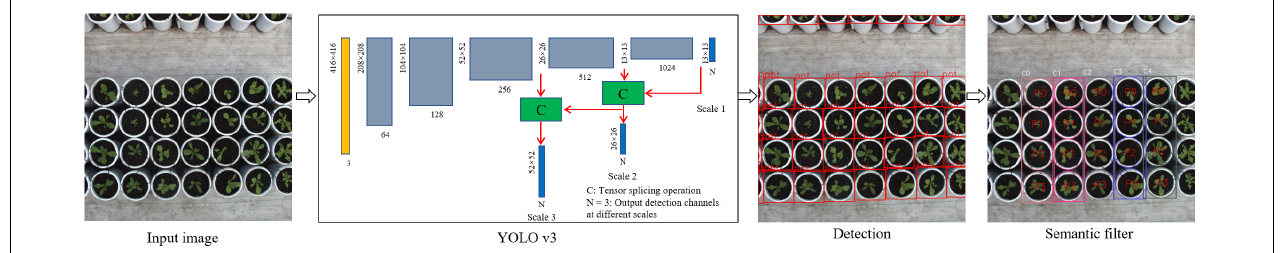
FIGURE 2 | Pot detection model and post-processing. Input images were scaled to 416 × 416 pixels and fed into the YOLO v3 model, resulting in a series of predicted boxes. Semantic filtering was performed to extract the valid boxes and assign the local variety and plant indices. C indicates tensor splicing operation, N = 3 represents the output detection channels at different scales, ‘pot’ represents the detected pot, ‘C-’ is the variety index, and ‘P-’ represents the plant index of the individual variety.